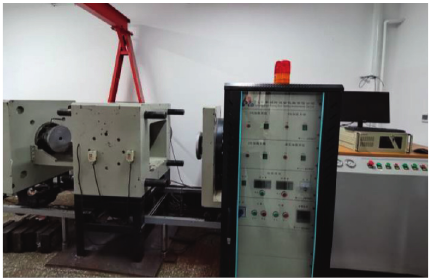
Figure 1: True triaxial hydraulic fracturing test system.